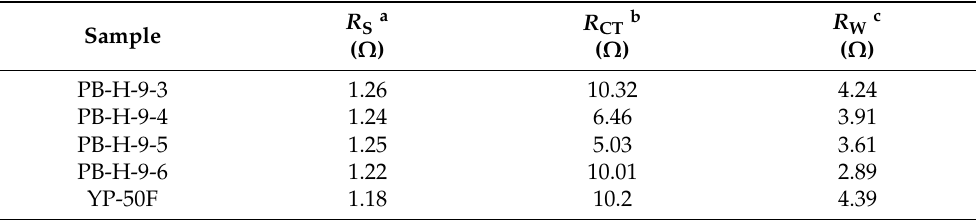
Table 2. Values of equivalent circuit parameters from fitting of the impedance spectra in Figure 8.